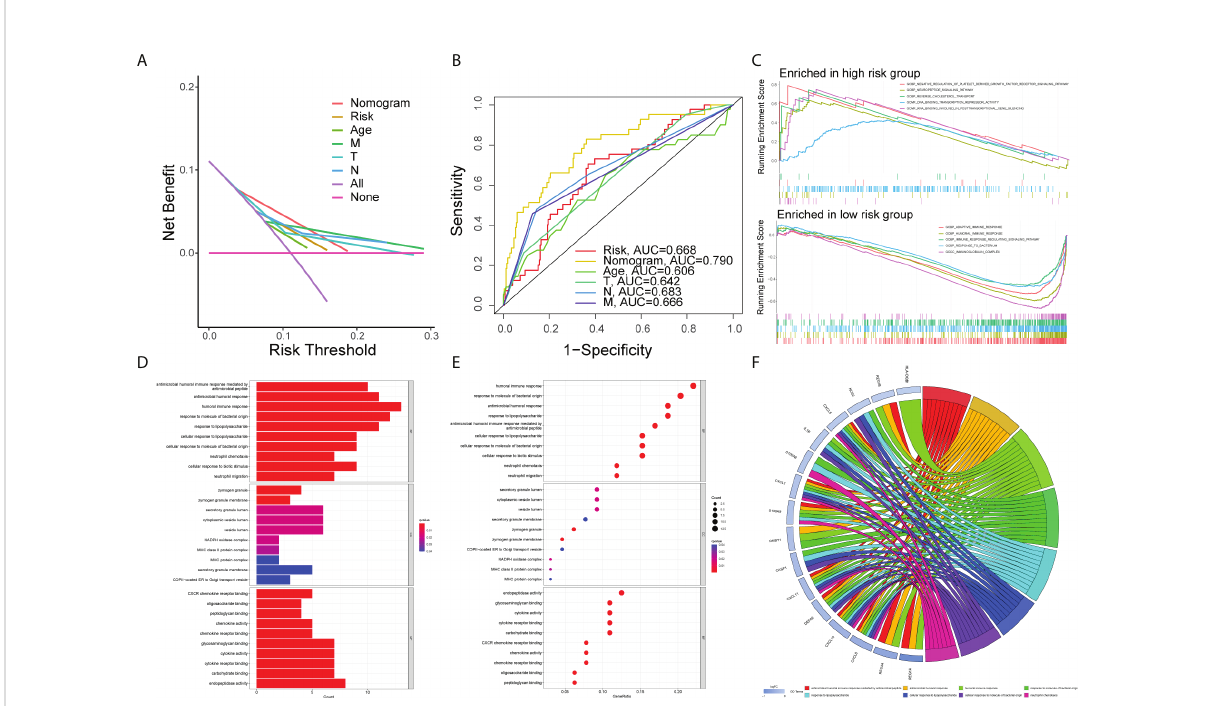
FIGURE 7 Gene set enrichment analysis. DCA curve (A) and ROC curve (B) of the nomogram, risk, and other clinicopathologic feature in COAD. (C) GSEA results illustrating 10 signi fi cant enrichment of GO in low-risk and high-risk groups. The results of GO enrichment analysis of the differentially expressed genes shown by barplot (D) , bubble chart (E) , and chord diagram (F)